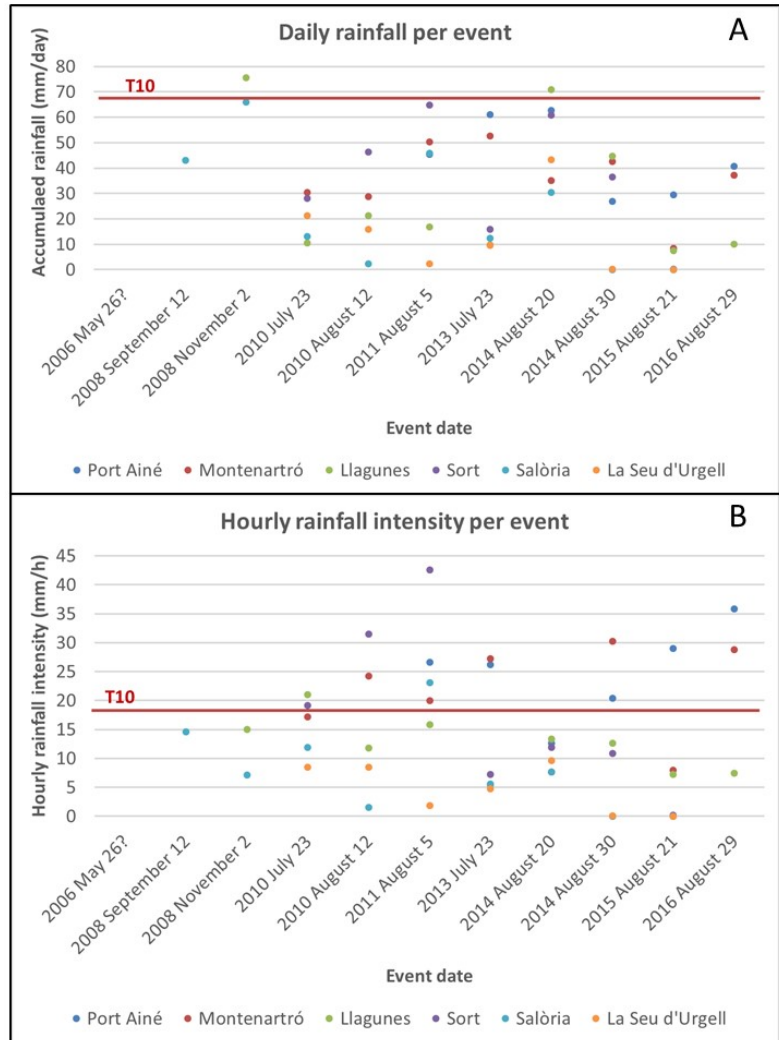
Figure 8. Comparison among the daily ( A ) and maximum hourly ( B ) rainfall intensity per event for the different meteorological stations close to and including Portainé. The calculated T10 daily rainfall value and the T10 hourly rainfall value extracted from the hyetographs, presented in Section 4.2.2, are shown with a red line.